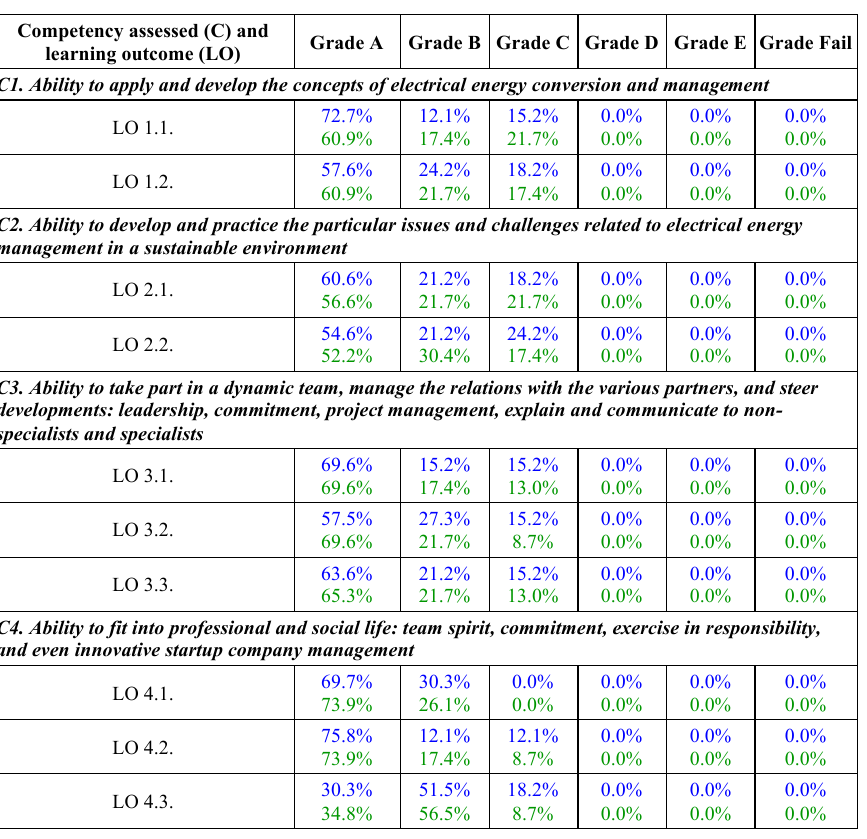
Table 2. Transcript of grades: score distributions. The students‘ results of the Class of 2016 (33 students were surveyed) and the Class of 2017 (23 students were surveyed) appear in blue and green ,